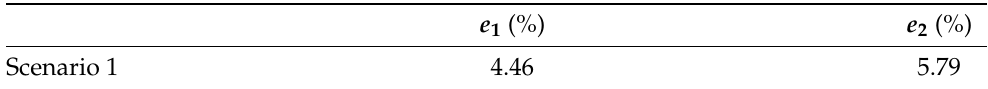
Table 3. Scenario 1: relative